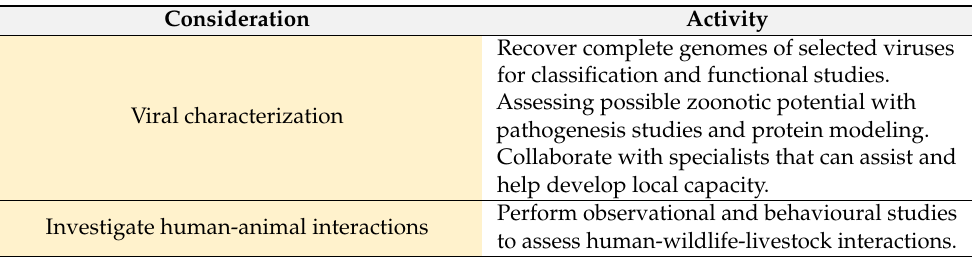
Figure S2: complete Bayesian BEAST phylogeny of African betacoronaviruses, Table S1: overview of bat surveillance nucleic acid detection studies, Table S2: molecular methodologies employed by the bat surveillance nucleic acid detection studies, Table S3: summary of bat host species tested for coronavirus RNA and positive species reported, Table S4: coronavirus surveillance performed per bat host species, Table S5: bat species from which coronaviruses have been reported (positive